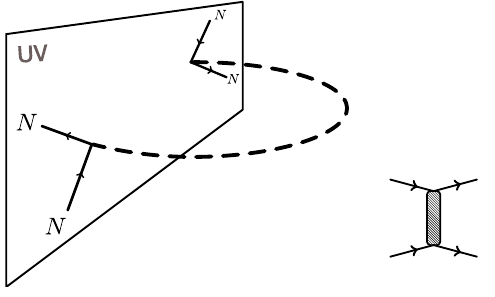
Figure 3 . Diagram in 5D anti-de Sitter space giving rise to the conformal